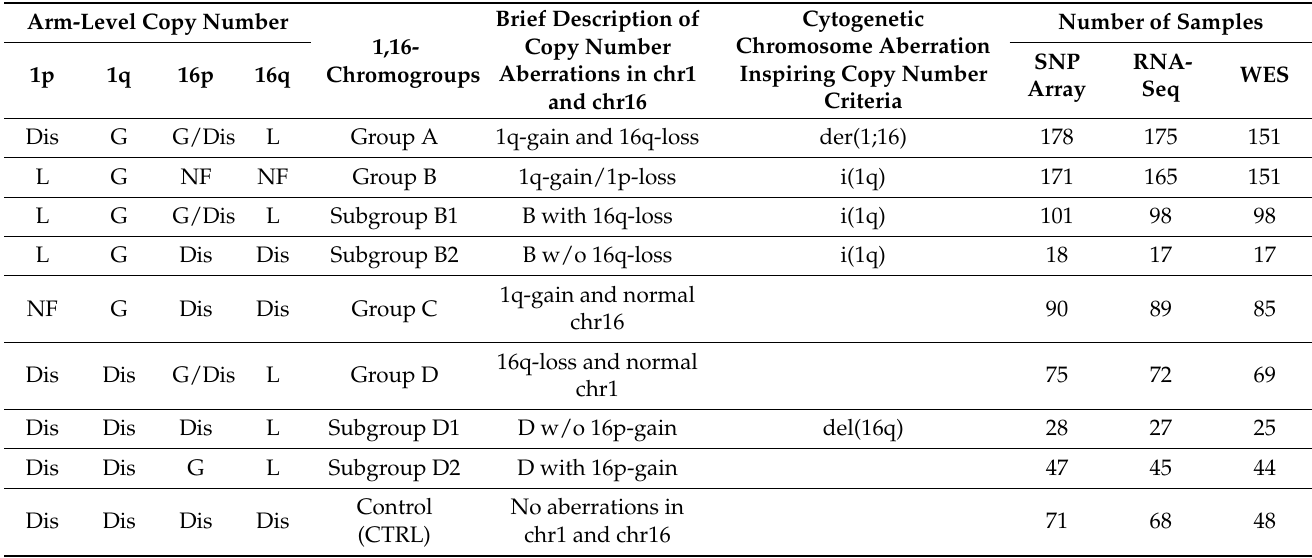
Figure 2. Schematic drawings of main cytogenetic aberrations in breast cancer and corresponding copy number changes. Left panel top: single copy of der(1;16) (q10;p10). Left panel bottom: 3 copies of der(1;16). Right panel top: isochromosome 1q (i(1q)), a chromosome formed by two long arms of chr1. Right panel bottom: deletion of long arm of chr16. Table 1. Number of samples and arm-level copy number criteria for each 1,16-chromogroups. G: gain; L: loss; Dis: disomy; NF: no filter during selection; w/o: without; SNP: single nucleotide polymorphism; WES: whole exome sequencing. For more details, see Table S1.